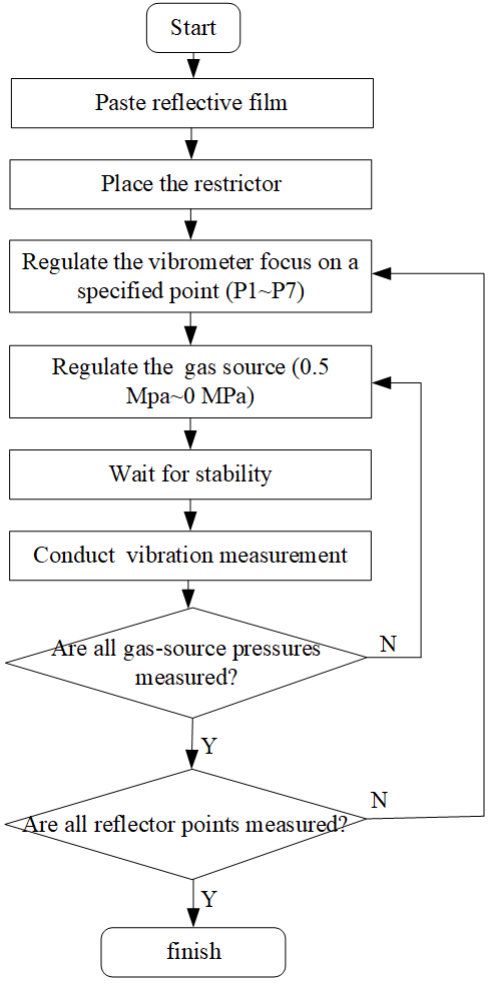
Figure 7. Block diagram of the measurement